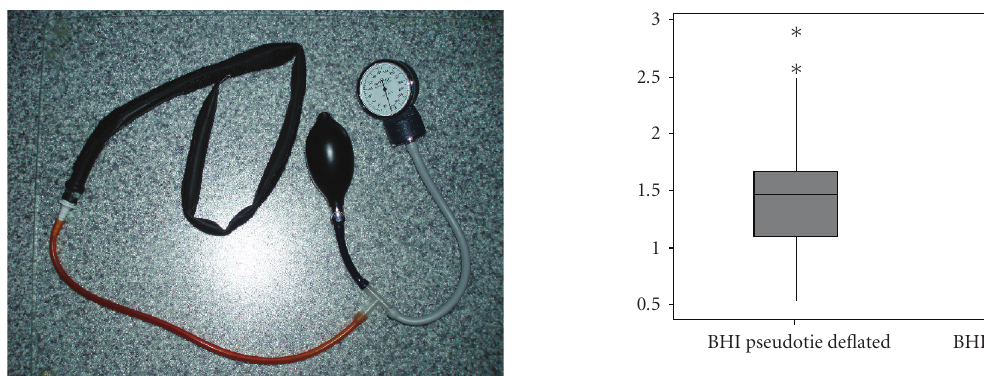
Figure 2: Cerebrovascular reactivity as measured by Breath hold index (BHI) with pseudo-tie deflated and inflated